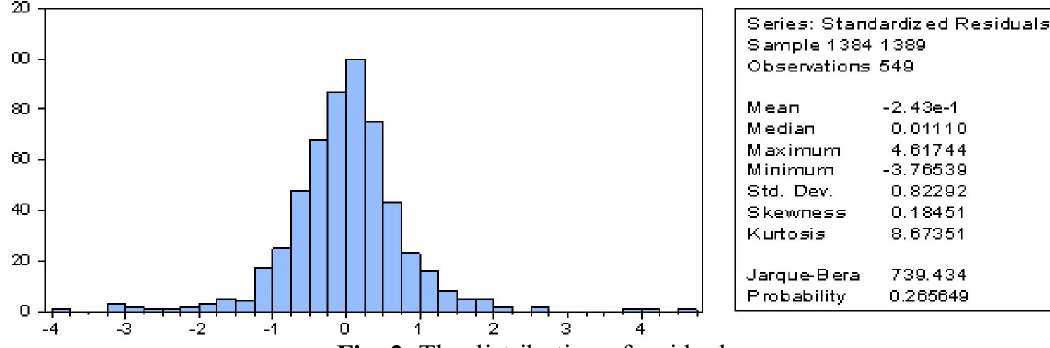
Fig. 2. The distribution of